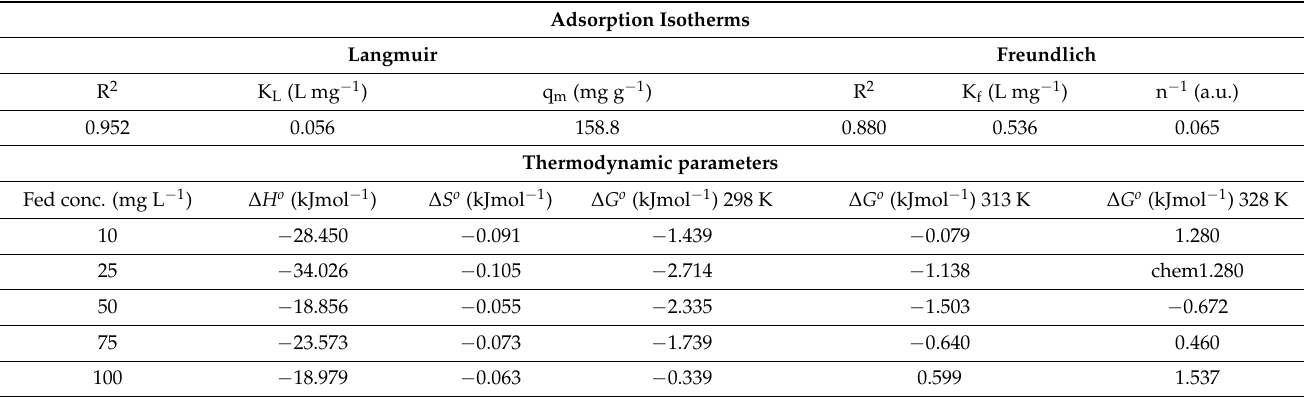
Figure 9. Thermodynamic study of the sorption of Rh-B on the synthesized V@TiO 2 at 298, 313, and 328 °K. Table 3. The isotherms and thermodynamic findings for the Rh-B sorption on the V@TiO 2 nanocom- posite.